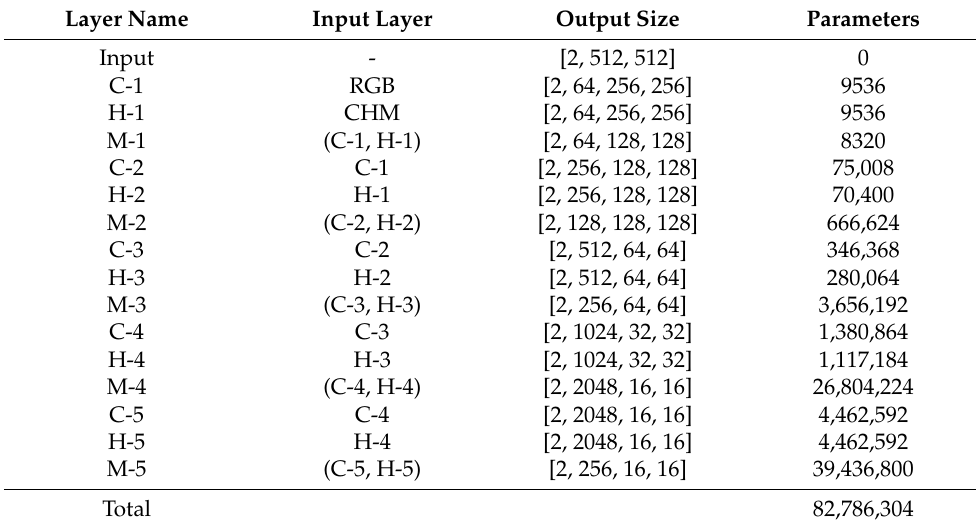
Table 3. The specific parameters of the ACNet network structure.